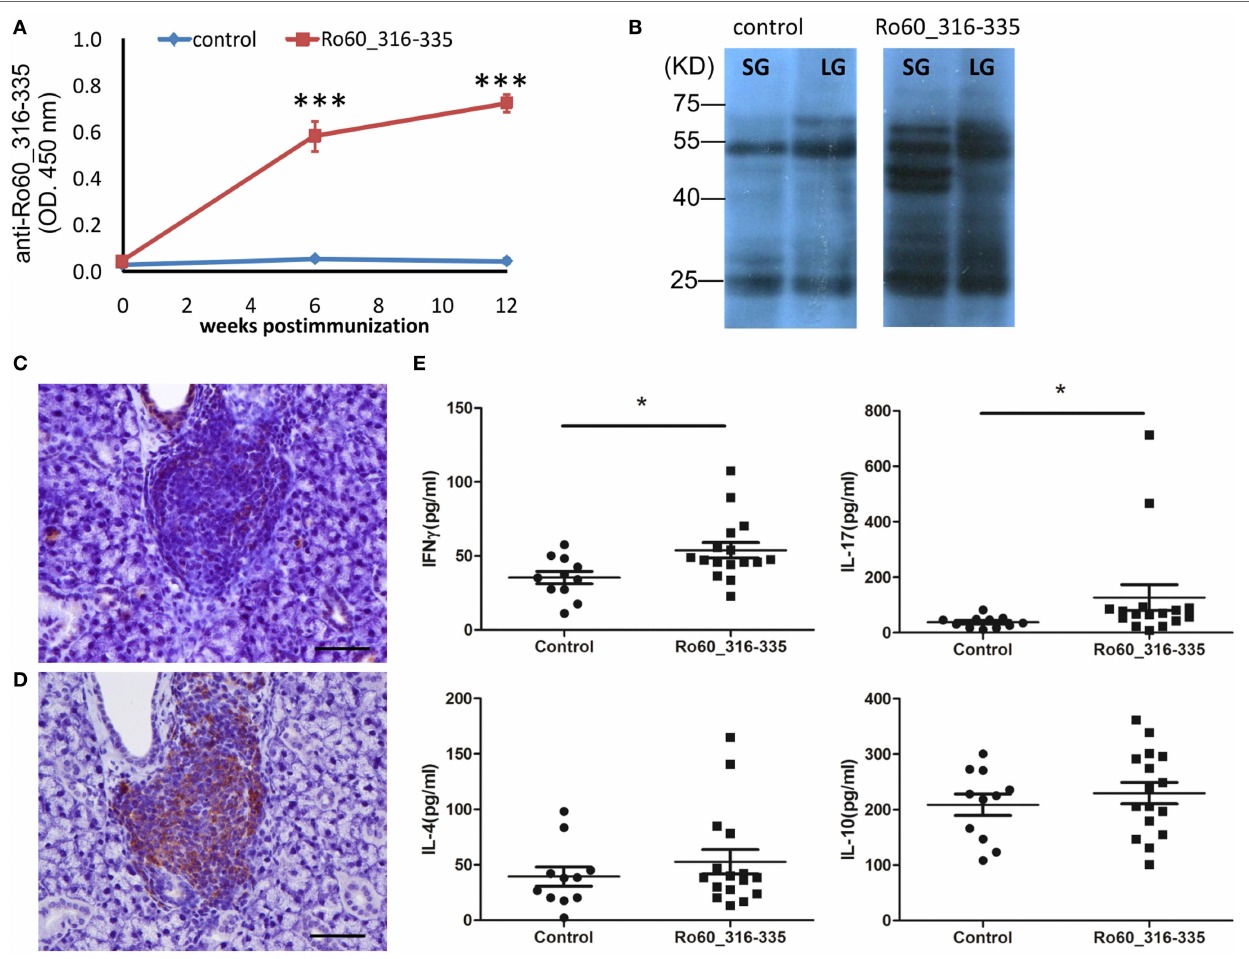
FigUre 2 | Immunological features of the primary Sjögren’s syndrome-like disease in C3H/He mice. (a) Autoantibodies against the Ro60_316-335 peptide in sera of Ro60_316-335 immunized ( n = 9) C3H/HeJ mice or controls ( n = 9). Results derived from one of two experiments performed are shown and data are presented as mean ± SEM. Statistically significant differences (* p < 0.05 and ** p < 0.01) were calculated by using the Mann–Whitney U -test. (B) Immunoblotting of lacrimal glands (LG) or salivary glands (SG) tissue lysates from healthy mice with sera from control or Ro60_316-335 immunized mice. Representative results are shown. (c,D) immunochemistry staining of murine CD3 T cells (c) and CD19 B cell (D) in the lymphocytic foci (bar length = 50 µm). (e) Concentrations of IFN- γ , IL-17A, IL-4, and IL-10 in the sera of Ro60_316-335 immunized C3H/HeJ mice ( n = 16) and controls ( n = 11). Statistically significant differences (* p < 0.05) were calculated by the Mann–Whitney U